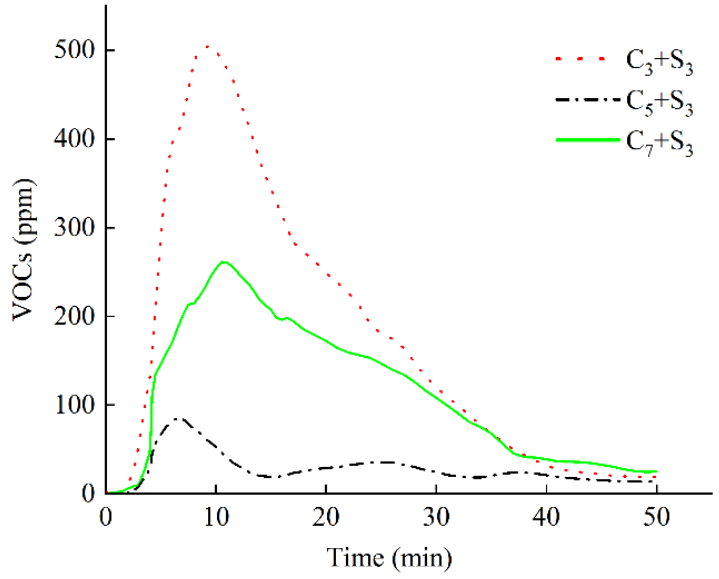
Figure 6. VOCs in heating emission of modified asphalt with different activated carbon content.